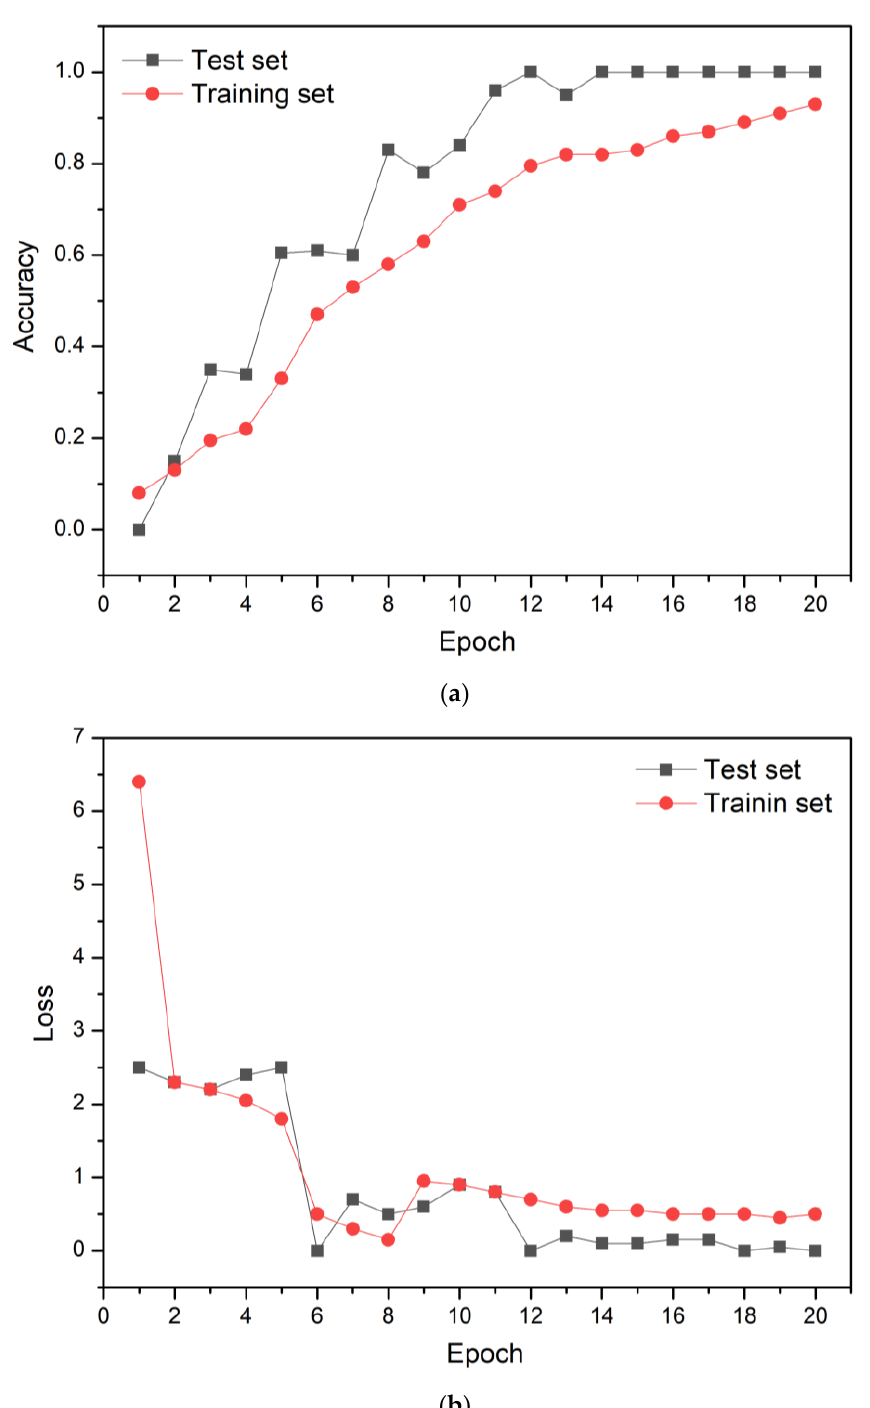
Figure 7. The learning ( a ) accuracy and ( b ) loss of the CNN model for 20 epochs.